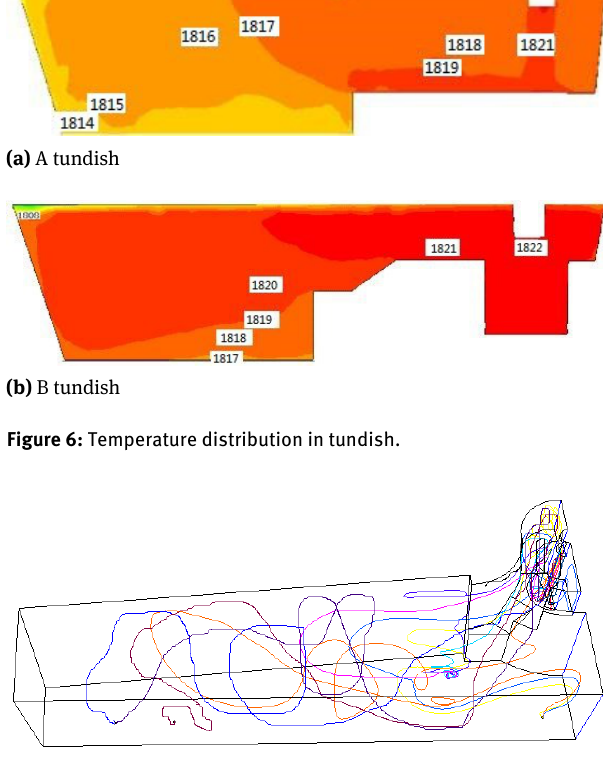
Figure 7: Trajectory of inclusions in tundish with turbulence in- hibitor B (d = 60